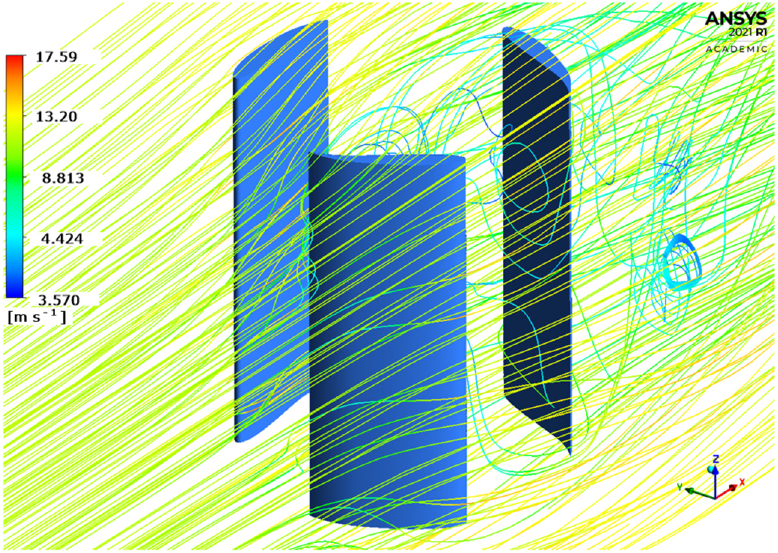
Figure 23. Velocity streamlines at wind speed 14 m/s and TSR of